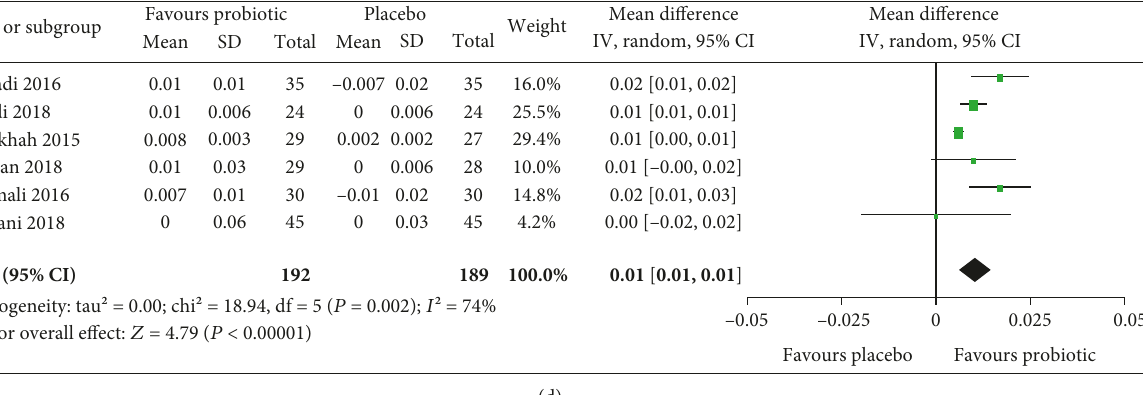
Figure 4: E ff ect of probiotic supplementation on blood glucose and related indicators: (a) FBG (mg/dL), (b) FSI ( μ IU/mL), (c) HOMA-IR, and (d) QUICKI in pregnant women with gestational